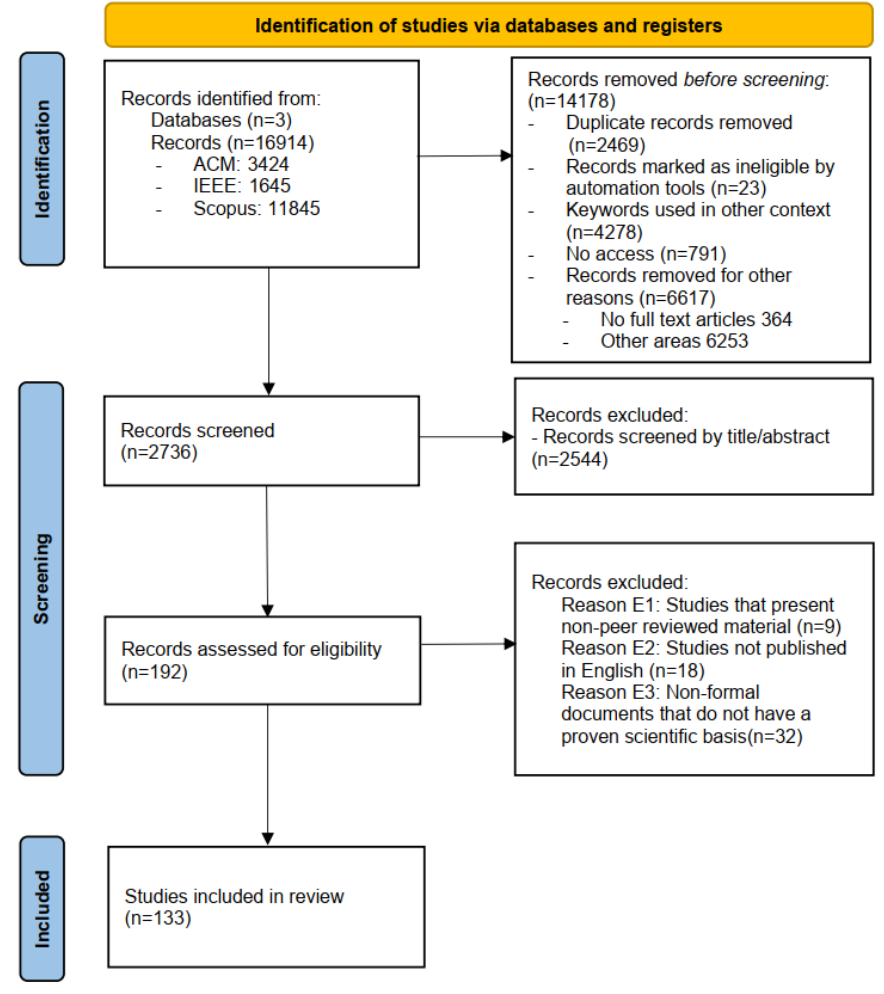
Figure 2. Process followed to obtain the AH systematic